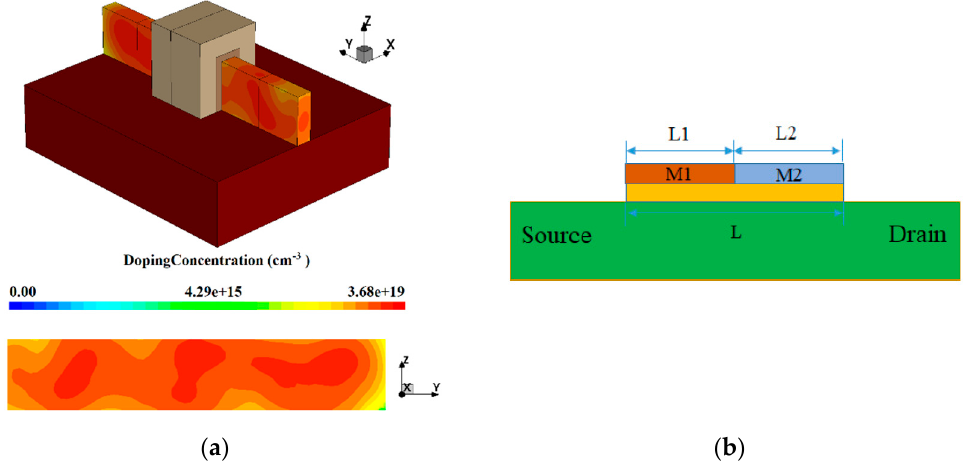
Figure 1. ( a ) Randmized doping profile and structure for dual-metal gate Junctionless FinFET, ( b ) Cross section along the x-axis at x = 0. The gate near the source is called the “control gate”, and the gate near the drain is called the “screen gate”.